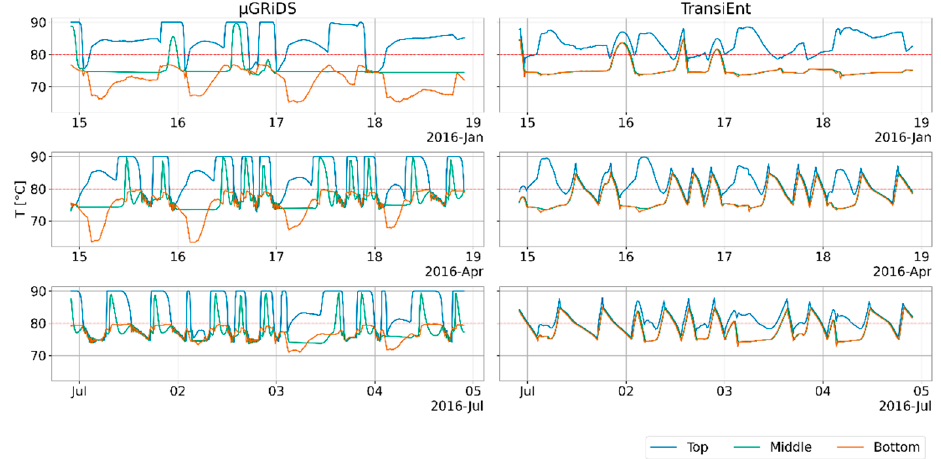
Figure 5. Temperature stratification for the µGRiDS and TransiEnt models in winter, transition, and summer seasons.